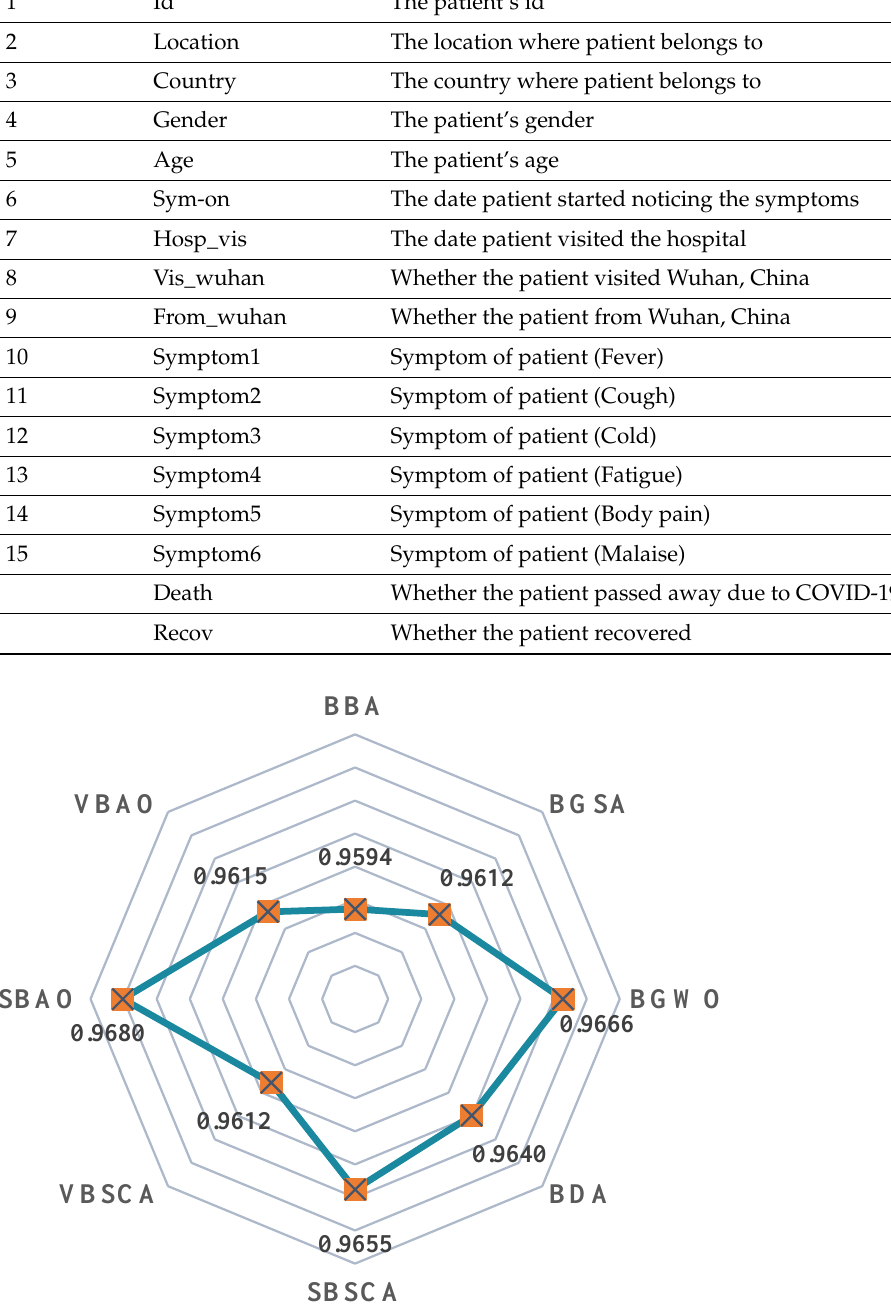
Figure 6. Accuracy gained by BAO and comparative algorithms.